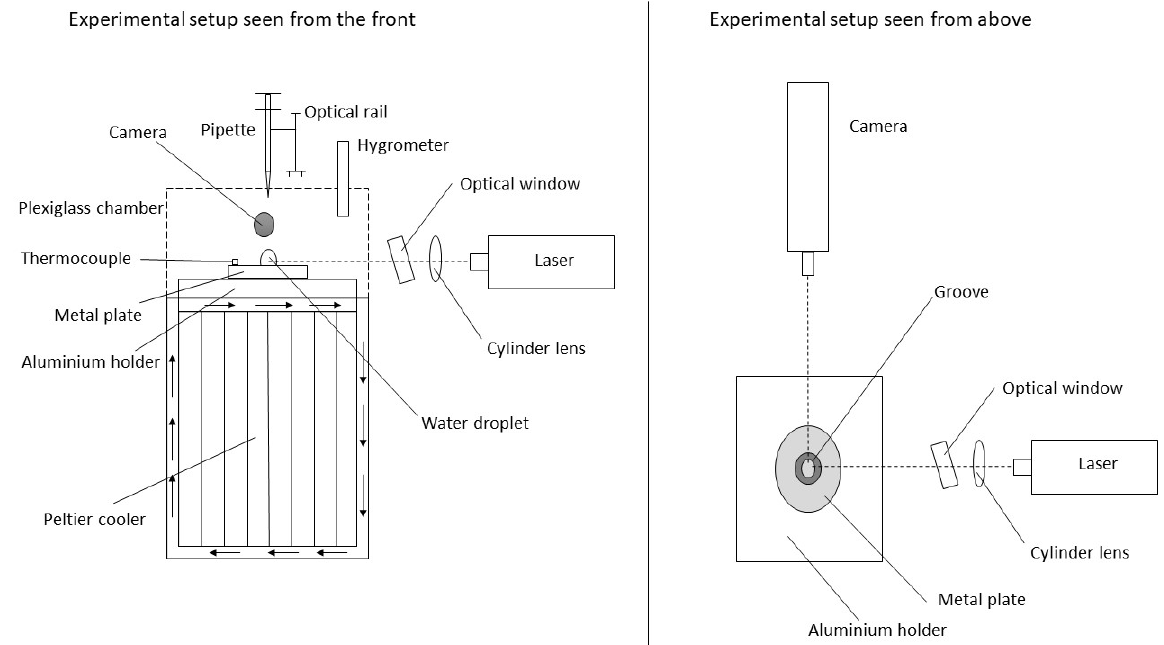
Figure 2. Schematic of the experimental